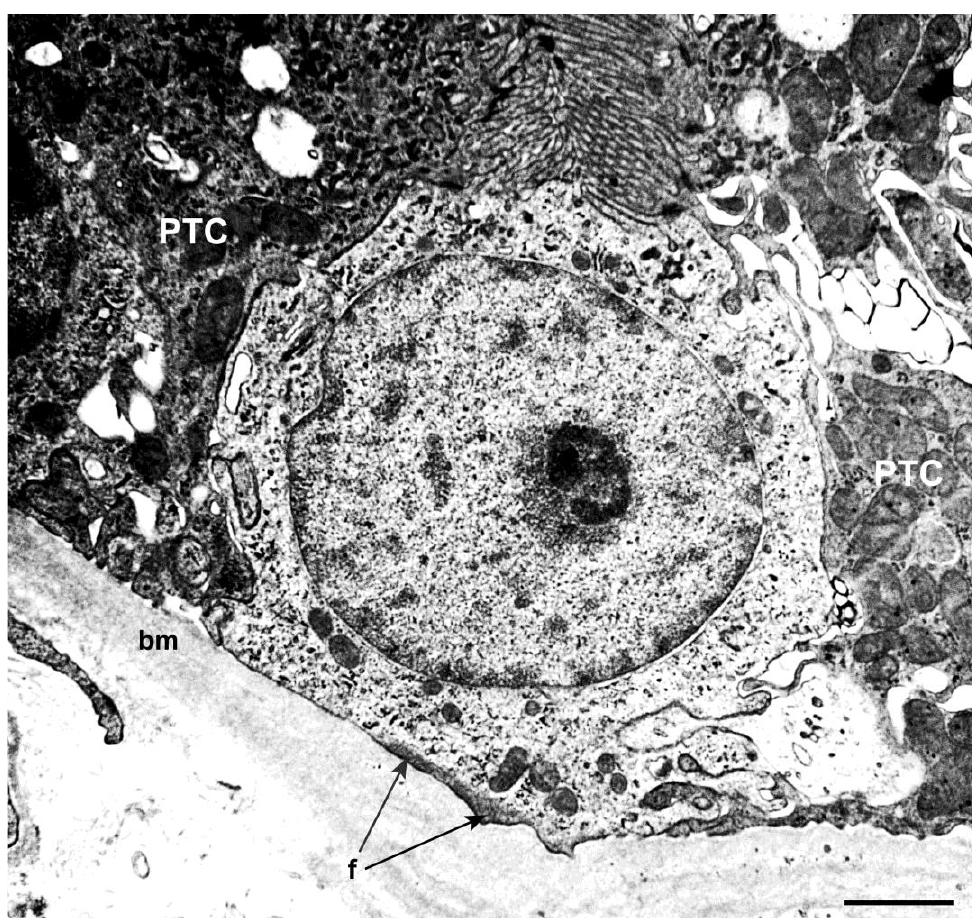
Figure 7. Ultrastructural image of an STC between two cells of the proximal tubule (PTC). Note the undifferentiated aspect and the presence of basal filaments (f: showed by the arrows). bm, basement membrane. Scale bar: 1 µm.